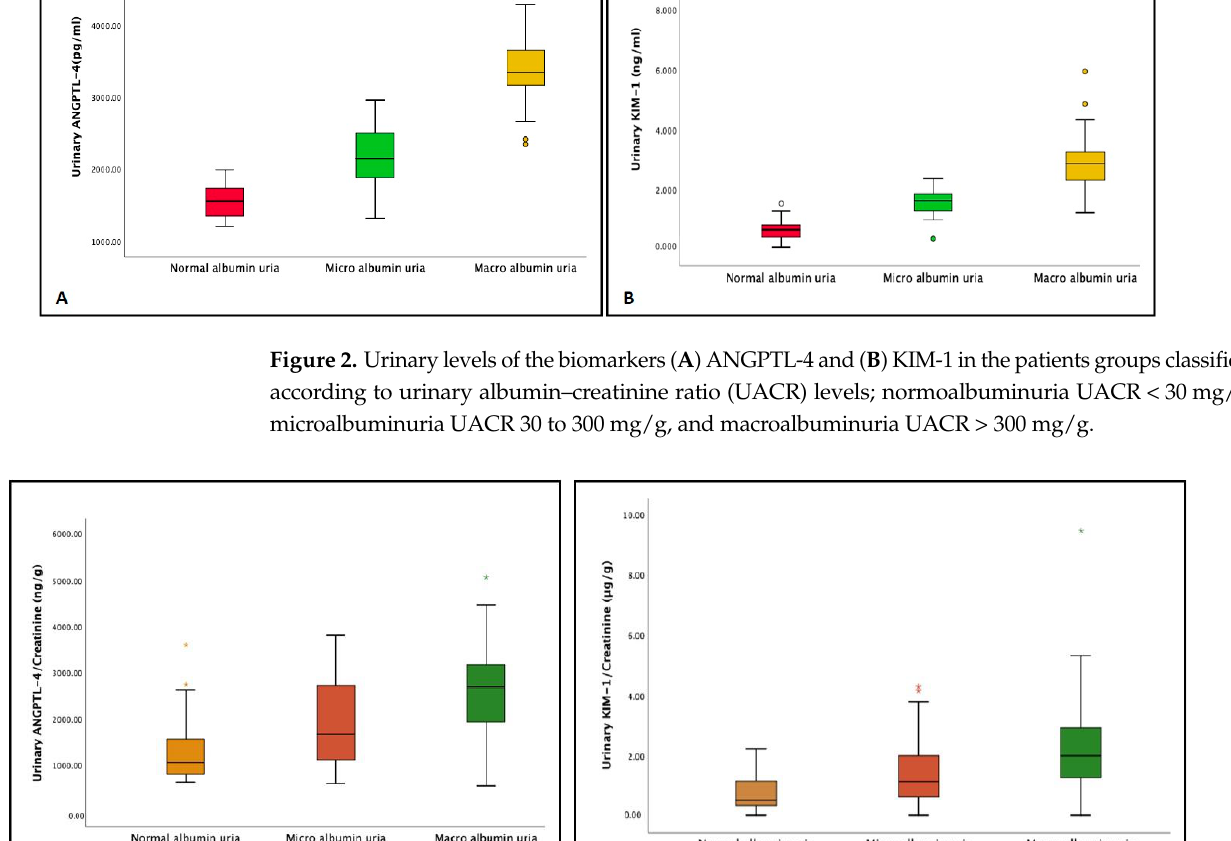
Figure 4. Urinary levels of the biomarkers ( A ) ANGPTL-4 and ( B ) KIM-1 in the patients classified on the basis of estimated glomerular filtration rate (eGFR) values into stage I CKD (eGFR > 90 mL/min/1.73 m 2 ), stage II CKD (eGFR: 60–89 mL/min/1.73 m 2 ), stage III CKD (eGFR: 30–59 mL/min/1.73 m 2 ), stage IV CKD (eGFR: 15–29 mL/min/1.73 m 2 ), and stage V CKD (eGFR < 15 mL/min/1.73 m 2 ). 3.3. Correlation of KIM-1 and ANGPTL-4 with Clinical Parameters The urinary concentration of ANGPTL-4 was positively correlated with age, duration of diabetes, FPG, HbA1c, urea, serum creatinine, urine albumin, and UACR in all three groups. Similarly, for urinary KIM-1 levels, a significant positive correlation was found with SBP, HbA1c, urea, BUN, serum creatinine, urine albumin, and UACR. Subsequent Spearman’s correlation revealed that both the urinary biomarkers ANGPTL-4 and KIM-1 were negatively associated with eGFR (ANGPTL-4: r = −0.2043; r = −0.5235; r = −0.8149, p < 0.0001; KIM-1: r = −0.3262; r = −0.6820; r = −0.8542, p < 0.0001) (Table 2).